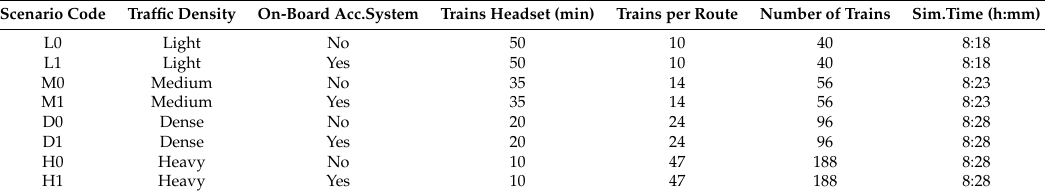
Table 3. Summary of the different proposed